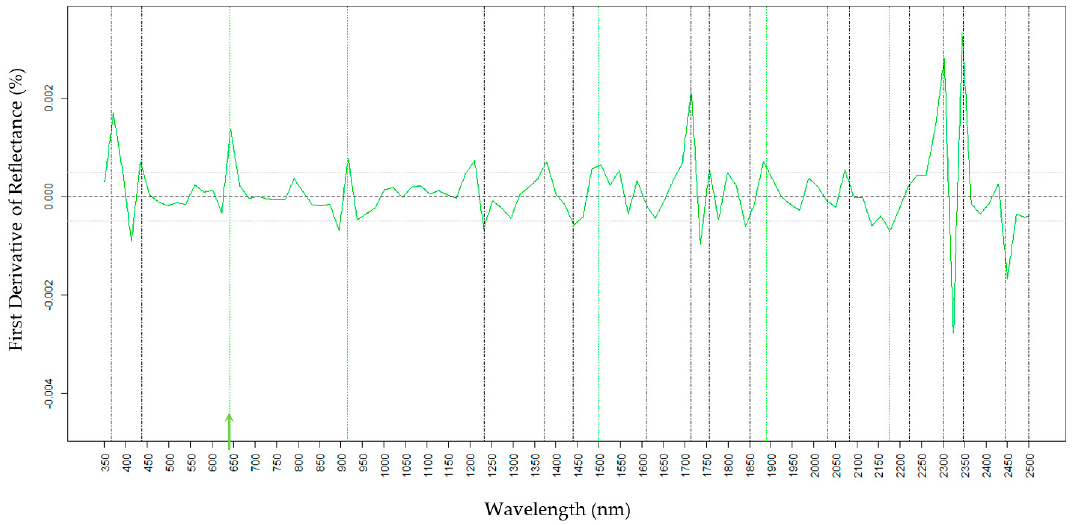
Figure 2. First derivative reflectance of pure Octacosanol-1. Black vertical lines indicate absorption features associated with H16, Octacosanol-1, and Triacontanol-1. Green lines are Octacosanol-1 specific. The green arrow at 645 nm depicts a unique absorption feature for Octacosanol-1.